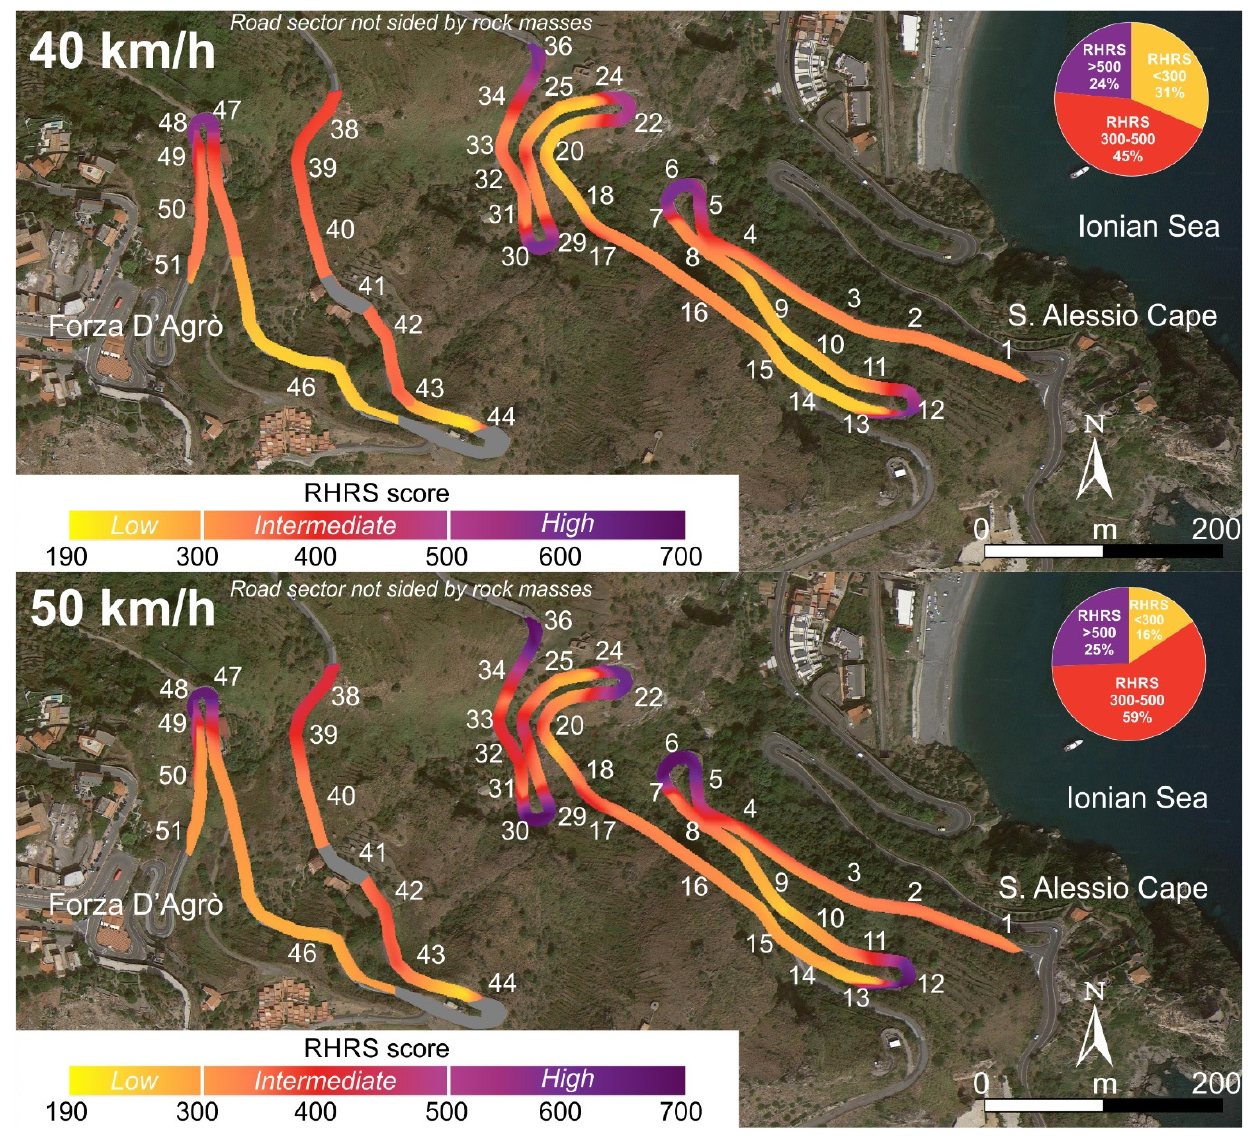
Figure 6. Risk maps for the 40 and 50 km/h vehicle speed scenarios considered. Numbers along the road path indicate the most representative sub-segments considered for the computation of the RHRS score. The gray band indicates road segments surrounded by no rock masses.